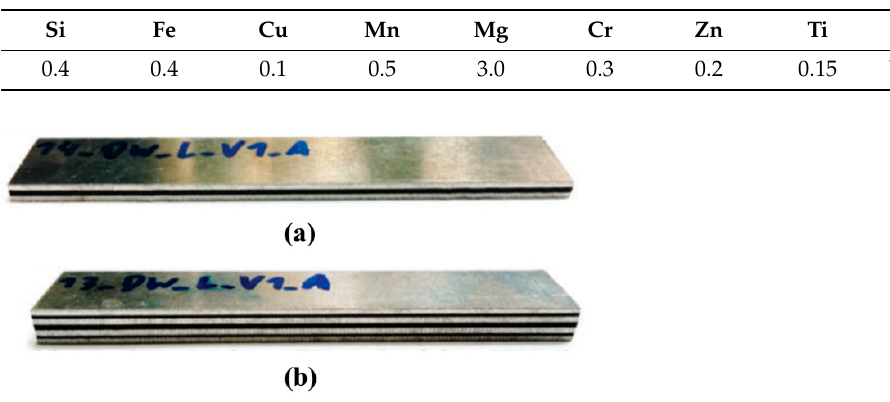
Table 2. Details of the designed lay-ups. Table 1. Composition of Al-5754 aluminium alloy (wt %). Table 1. Composition of Al-5754 aluminium alloy (wt %).